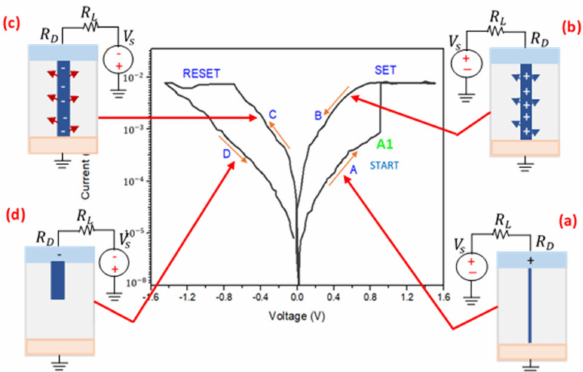
Figure 2. Typical bipolar switching (I-V) curve, similar to the one obtained in the TiN/ZnO/Pt device under sweeping mode [13], and schematic of the processes ( a – d ) during the formation and dissociation of CF in RRAM [15]. From the inset: ( a ) shows the formation of cylindrical CF after the applied positive bias as a SET process; ( b ) shows when the device is ON/LRS, and the blue arrows depict the generated radial electric field within the device vicinity; ( c ) shows when the device gained opposite polarity, and the red arrows depict the unfavorable states as a RESET process; and ( d ) shows when the device is transformed to an insulating state (after the dissociation of CF) OFF/HRS. Note: the inset and the pictures are arranged in the SET to RESET processes’ cycle (cycling along ( a – d